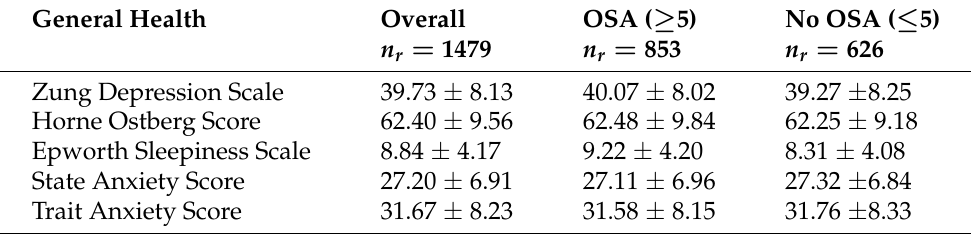
Table A5. General health characteristics of cohort expressed as mean ± standard deviation.